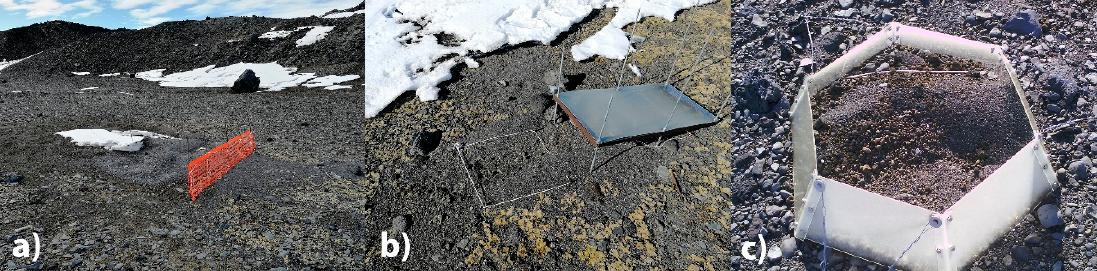
Figure 7. Details of the manipulation experiments that acted as obstacles and provided the accumulation of aeolian sedi- ment. ( a ) SF, ( b ) TT, ( c ) OTC2. Please note that the mosses, especially within the OTC, are completely covered by gravel and sand.